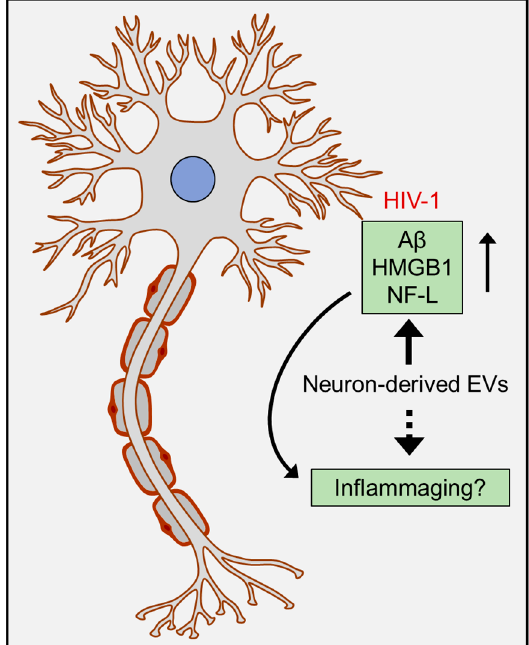
Figure 3. Alzheimer’s like neuropathology in HIV-1 leads to inflammaging: Amyloids that are synthesized by the neurons and non-neuronal cells in the presence of HIV-1 in the CNS can lead to neuroinflammation either directly, or via the amyloid carrying EV cargoes. Accumulation of amyloids causes tissue damage and leads to inflammation and infiltration of immune cells into the brain, in turn, resulting in the activation of glial cells and production of proinflammatory mediators. furthermore, these pathways can trigger a vicious cycle leading to increased production of amyloids and chronic neuroinflammation, ultimately culminating in inflammaging.